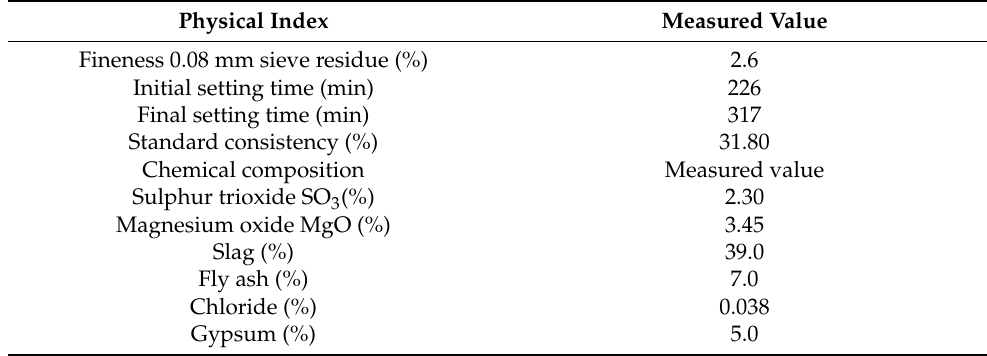
Table 2. Physical properties and chemical properties of cement used in this